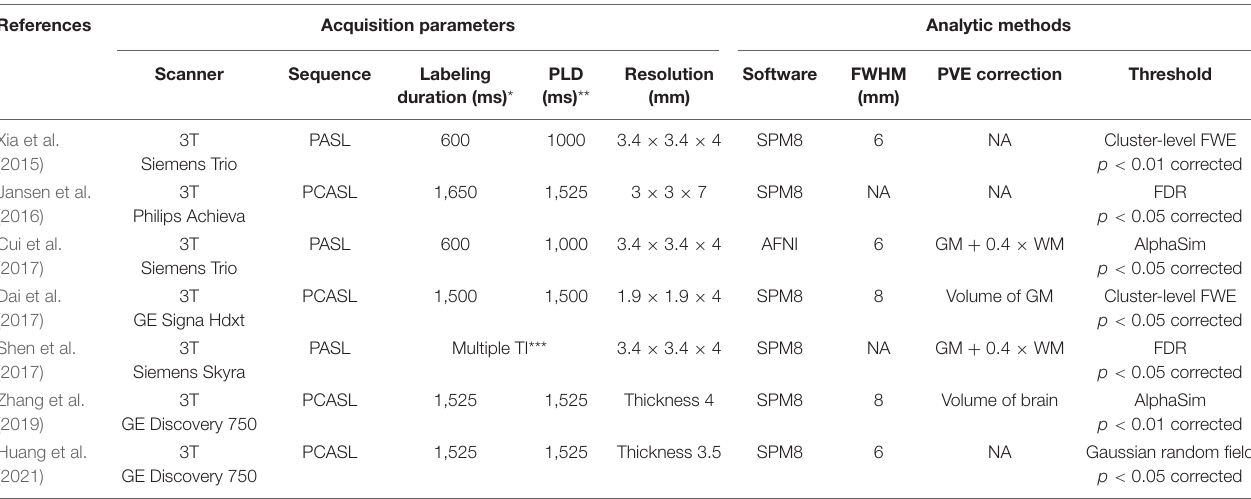
TABLE 3 | Acquisition parameters and analytic methods of the included studies in the